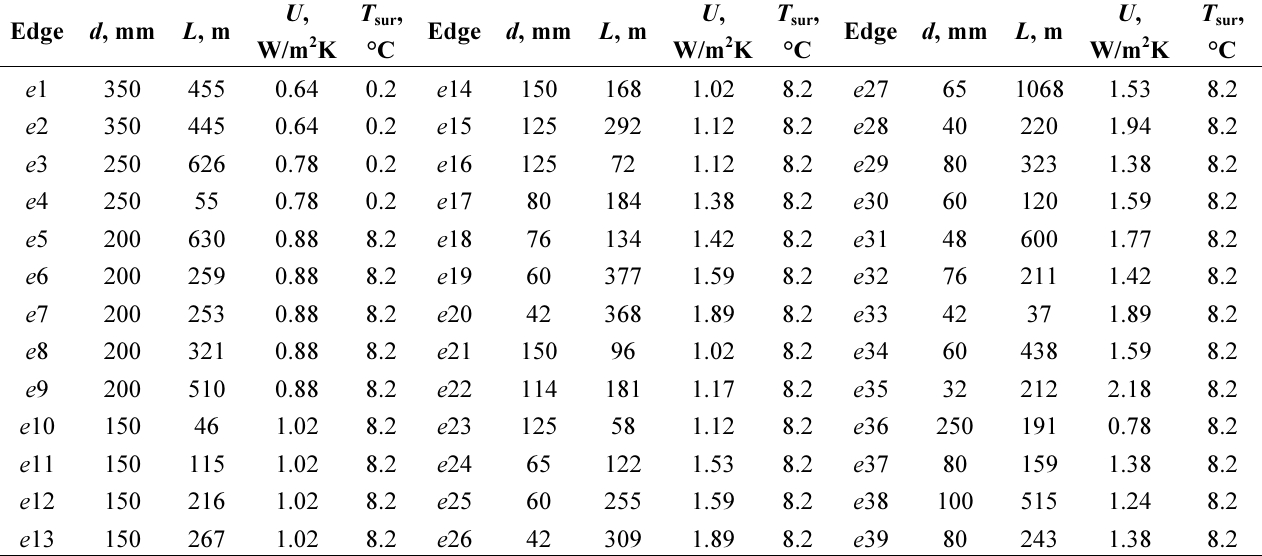
Table 2. Physical parameters of edges in DN in Šaleška valley (stationary conditions on a winter